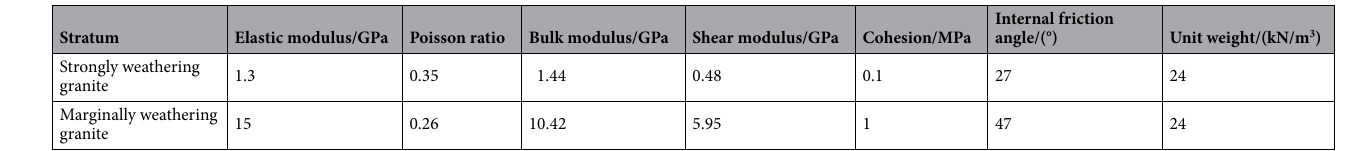
Table 6. Stratum parameters used in the numerical calculation (level-IV1 surrounding rock).